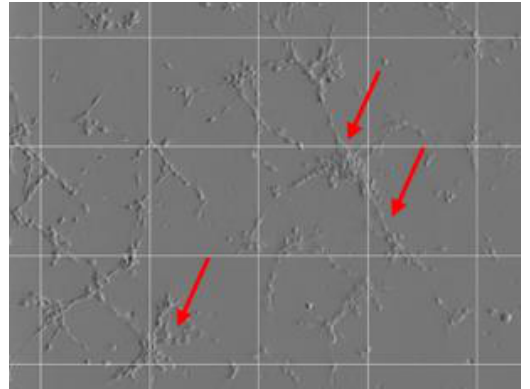
Figure 7. A sample phase contrast image of the EPCs forming microtubules on Cultrex ® basement membrane 10 h after cell seeding in conditioned medium. The gridlines were used to quantify the formation of new tubules without duplicating samples. Representative image chosen.